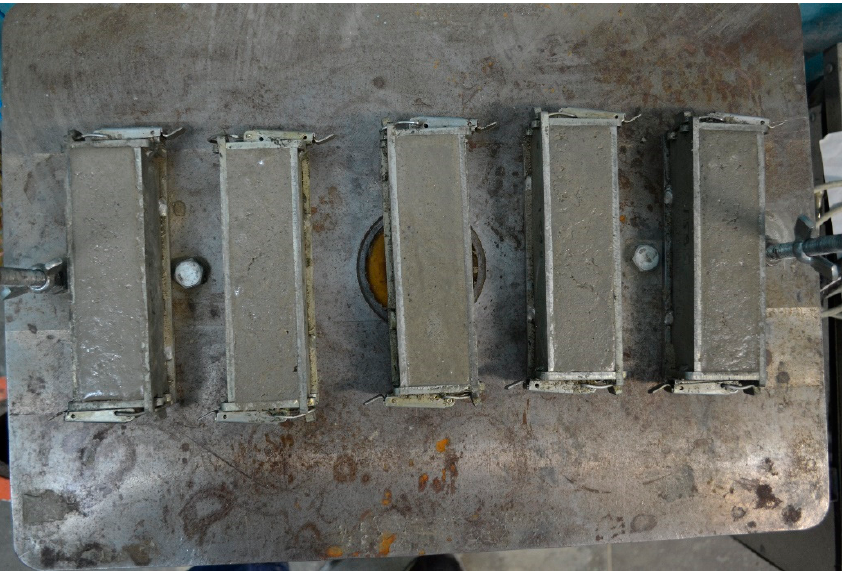
Figure 5. The process of vibration compaction of samples of geopolymer fine-grained concrete.